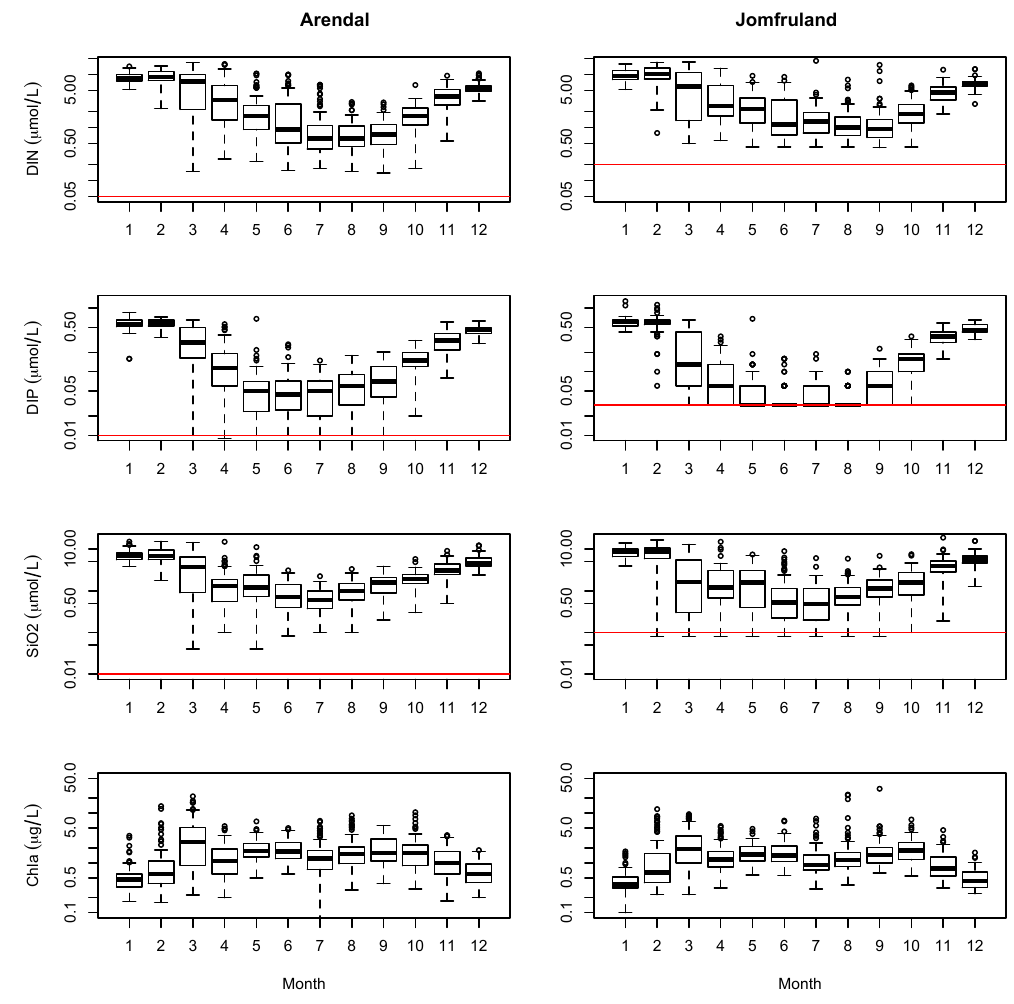
Fig. 2. Box-and-whisker plots showing the seasonal concentrations of DIN, DIP, SiO 2 and Chl- a at Arendal and Jomfruland. The nutrient concentrations are inµmoll − 1 and Chl- a in µgl − 1 . The y-axes are log-scaled, and the detection limits for the nutrients are indicated with red horizontal